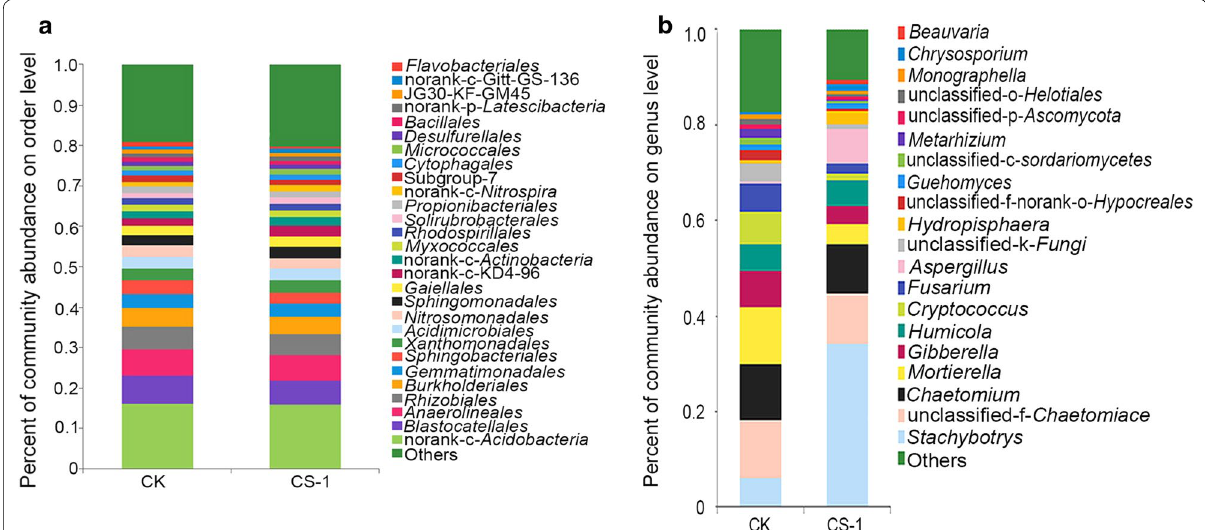
Fig. 5 Relative abundance of bacteria (genus levels) and fungi (order levels) in CS-1 and control treatments. The relative abundance (%) of all bacte- ria ( a ) and fungi ( b ) on the order and genus levels, respectively, in the rhizosphere soil of CS-1 and control treatments